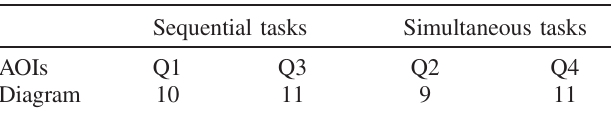
TABLE I. Number of AOIs in the diagram for the sequential and simultaneous synthesis tasks. Sequential